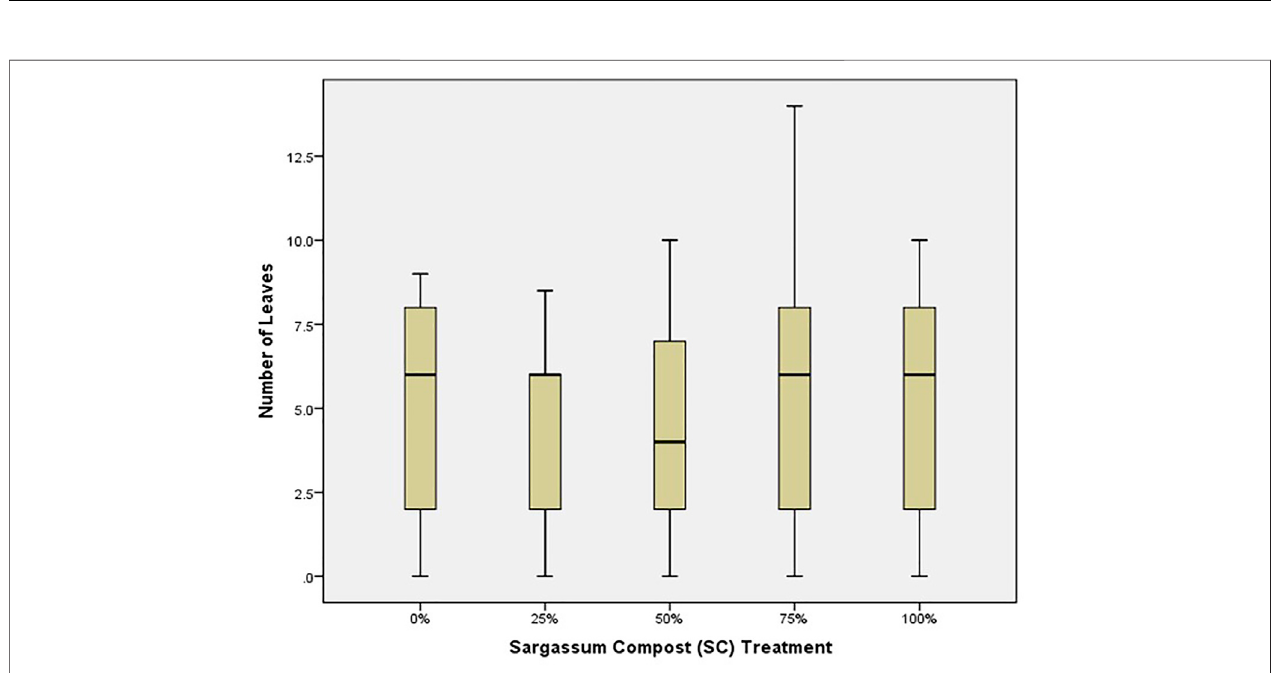
FIGURE 2 | Median number of leaves (bar), 25 – 75% range (box), and non-outlier range (whisker) for red mangrove seedlings in each treatment, indicating the % Sargassum spp. compost (SC).